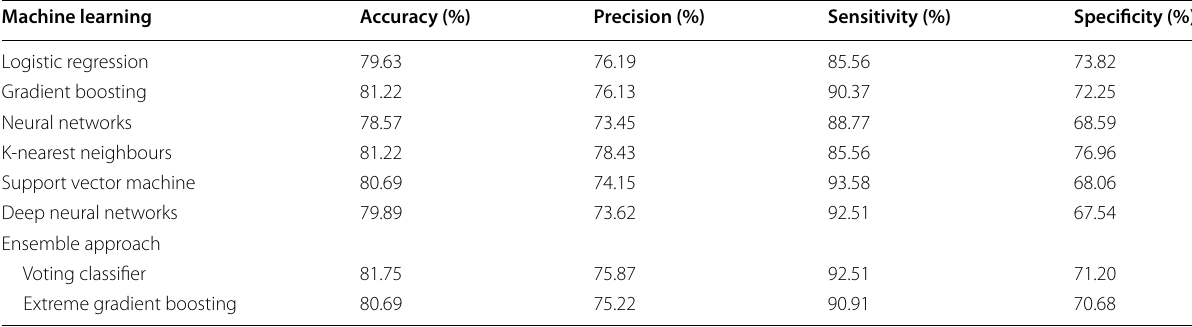
Table 1 Preliminary results